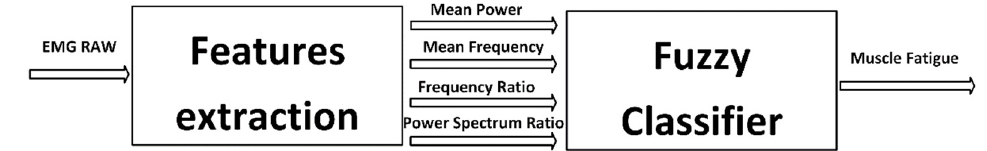
Figure 9. Muscle fatigue estimation.